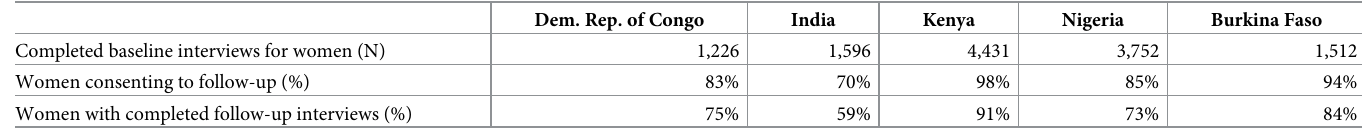
Table 1. Female client interviews at baseline and follow-Up in Burkina Faso, DRC, India, Kenya and Nigeria, PMA Agile 2017–2020.